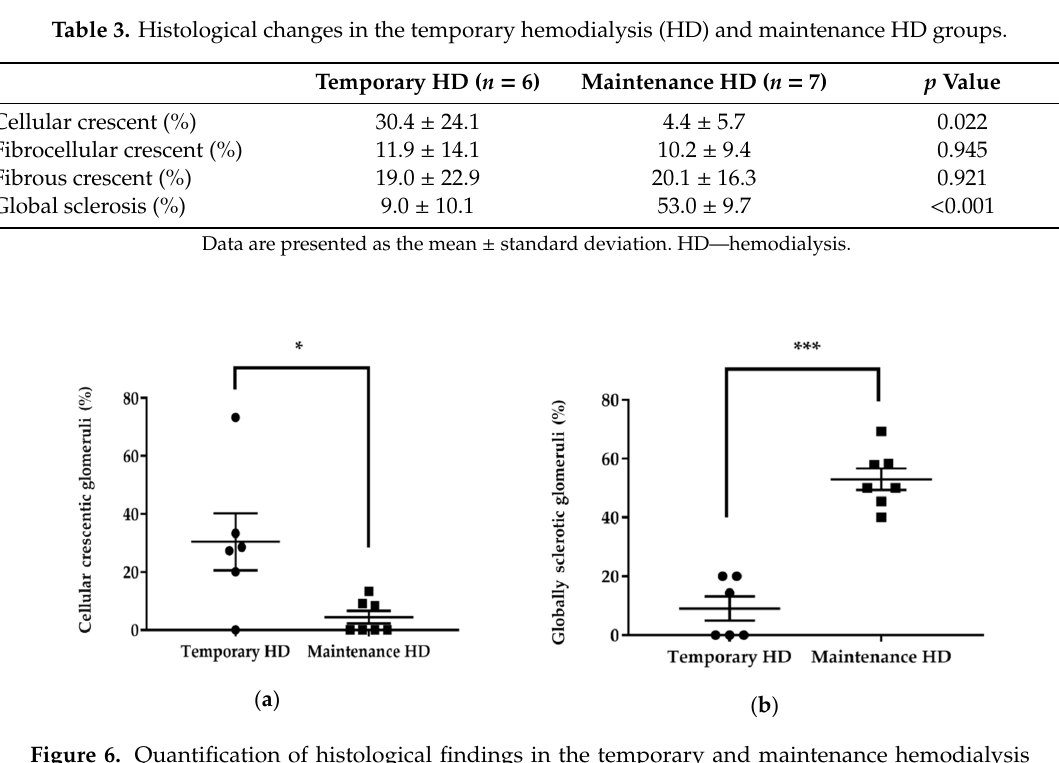
Figure 6. Quantification of histological findings in the temporary and maintenance hemodialysis (HD) groups. ( a ) Comparison of the percentage of glomeruli with cellular crescent between the temporary and maintenance HD groups. ( b ) Comparison of the percentage of globally sclerotic glomeruli between the temporary and maintenance HD groups. Bars indicate mean ± SEM. *, p < 0.05; *** p < 0.001. HD — hemodialysis.